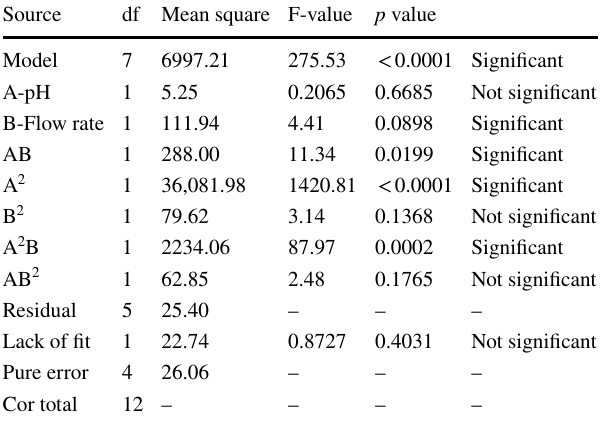
Table 8 Characteristics of raw and treated effluents in three stages of treatment